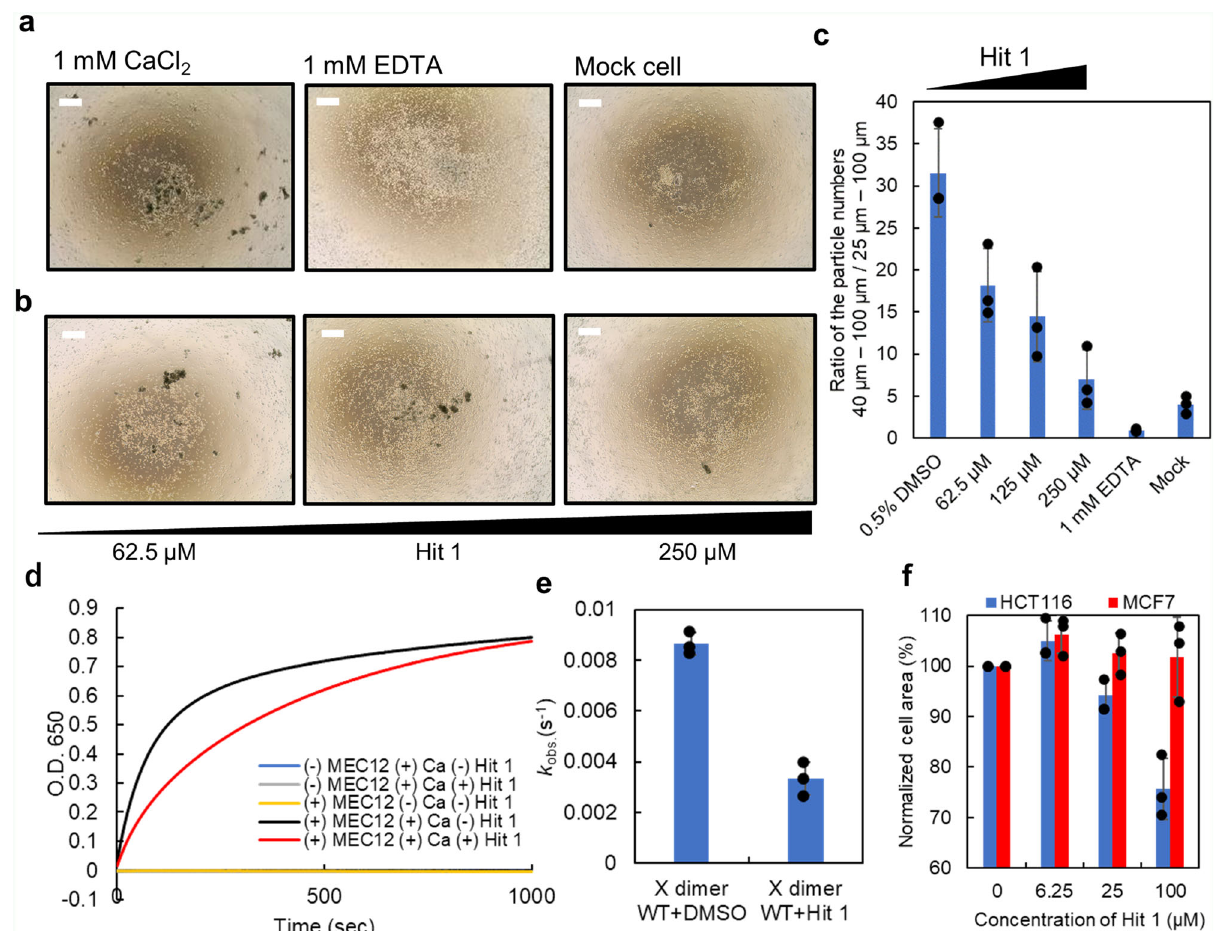
Fig. 4 Hit 1 blocks aggregation of liposomes and cells with P-cadherin on their surfaces. a Images of CHO cell line expressing P-cadherin in the presence of 1 mM CaCl 2 and 1 mM EDTA and a mock cell line. Scale bars indicate 500 µ m. b Representative images of CHO cell line expressing P-cadherin in the presence of 1 mM CaCl 2 and increasing concentrations of Hit 1. This experiment was repeated three times, and similar results were obtained. Scale bars indicate 500 µ m. c Quanti fi cation of cell-aggregation assay using MFI. Hit 1 inhibited the formation of cell aggregation in a dose-dependent manner. N = 3. Error bars show standard deviation. d Liposomes with MEC12 on the surface were incubated with CaCl 2 and with (red) or without (black) Hit 1. Controls had no effect on optical density (blue, yellow, and gray traces). A representative plot of optical density at 650 nm is shown as a function of time. N = 3. e The k obs of liposome aggregation was calculated assuming a one-phase association model. N = 3. Error bars show standard deviation. f Normalized area of HCT116 and MCF7 cells in the presence or absence of Hit 1. In order to take cell shape into account, the cell area in the absence of Hit 1 was taken as 100%. N = 3. Error bars show standard deviation. Individual data points are shown in black